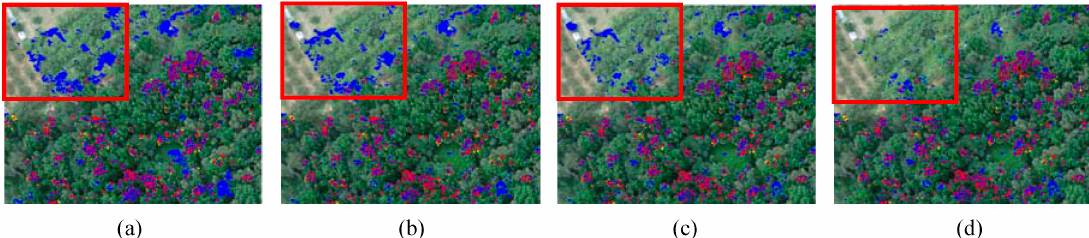
( a ) Traditional CEM; ( b ) Subset CEM; ( c ) SW CEM; ( d ) ASW CEM.